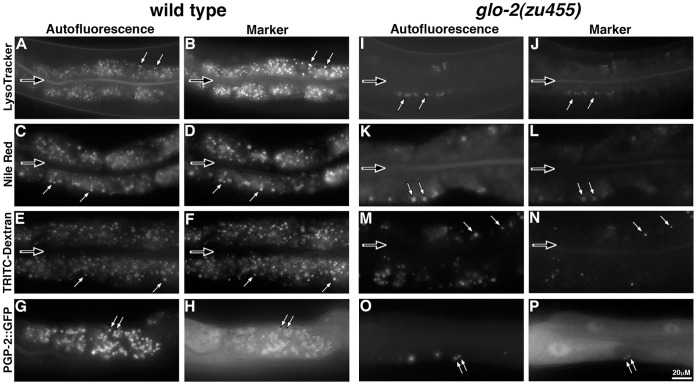
Gut granule formation in adults.In wild-type adults, autofluorescent gut granules accumulated markers of acidification (A–B), hydrophobicity (C–D), terminal endocytic compartments (E–F) and contained PGP-2::GFP (G–H). glo-2(zu455) adults had substantially reduced numbers of autofluorescent compartments (I). The majority of these organelles were stained with LysoTracker Red (I-J), Nile Red (K–L) and contained PGP-2::GFP (O–P). (M–N) In contrast, few of the autofluorescent compartments accumulated TRITC-Dextran and those that did localized the marker to a subdomain within the organelle. In all panels, white arrows identify autofluorescent compartments that contained the gut granule marker. The black arrows denote the location of the intestinal lumen.